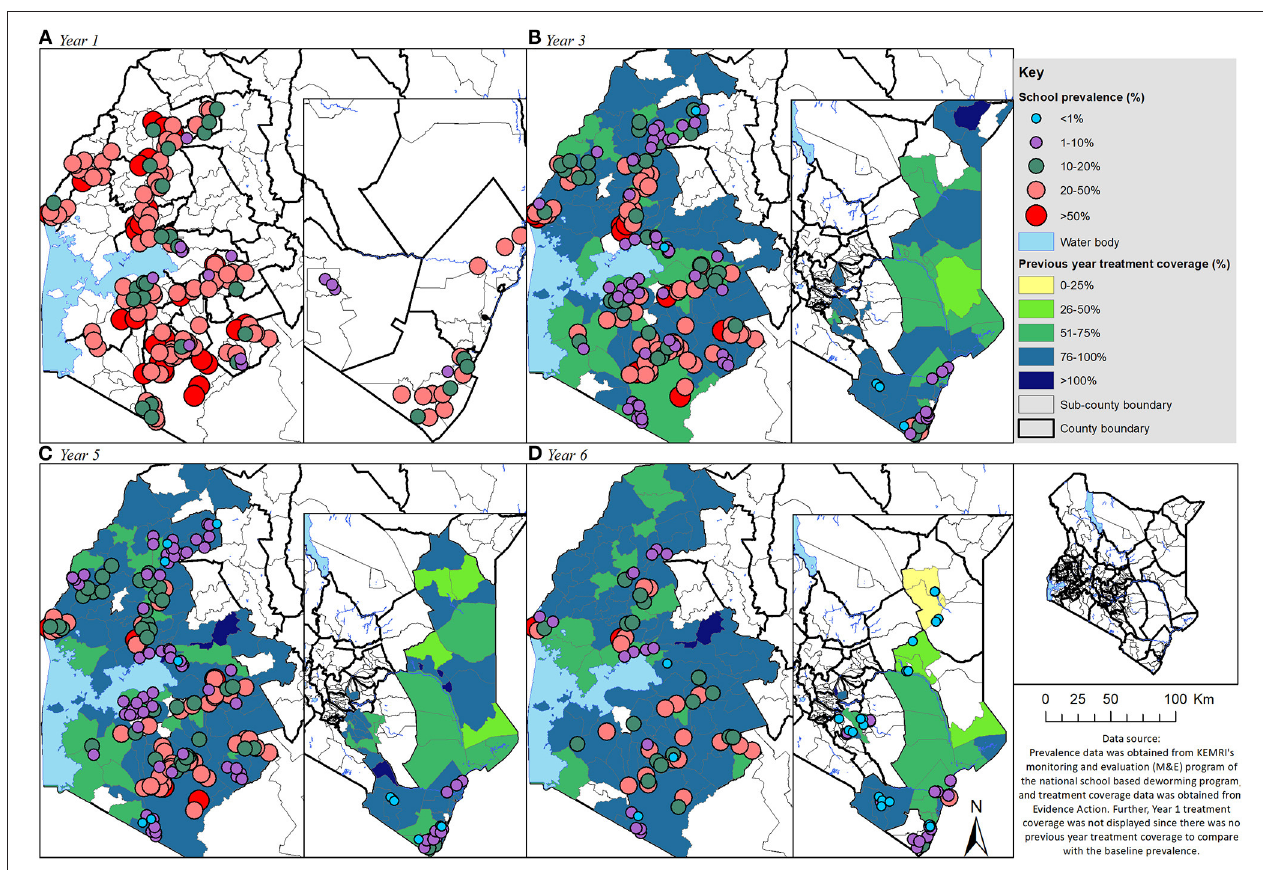
FIGURE 4 | Geographical distribution of the undifferentiated STH pre-treatment prevalence overlaid with the previous year treatment coverage ( A : Year 1, B : Year 3, C : Year 5, and D : Year 6) for the school aged (SAC) group of children in